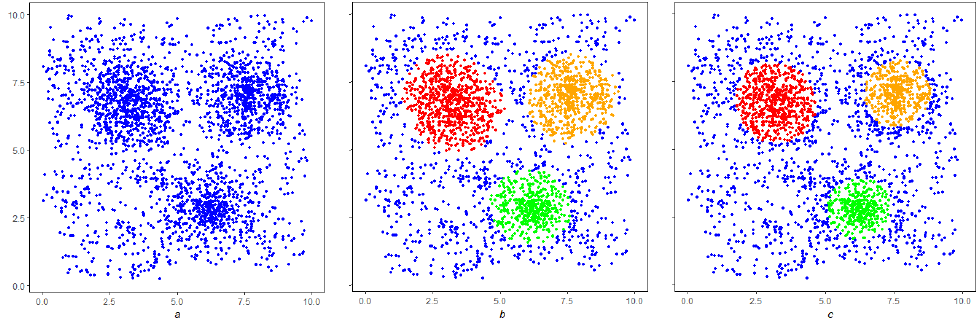
Figure 3. The inverse character of the dependence of the first stage of SDPS on the density level, where ( a ) is the initial array X and ( b , c ) have sets shown in red, yellow, and green for SDPS ( α , r , p )( X ) and SDPS ( ¯ α , r , p )( X ) for α < ¯ α